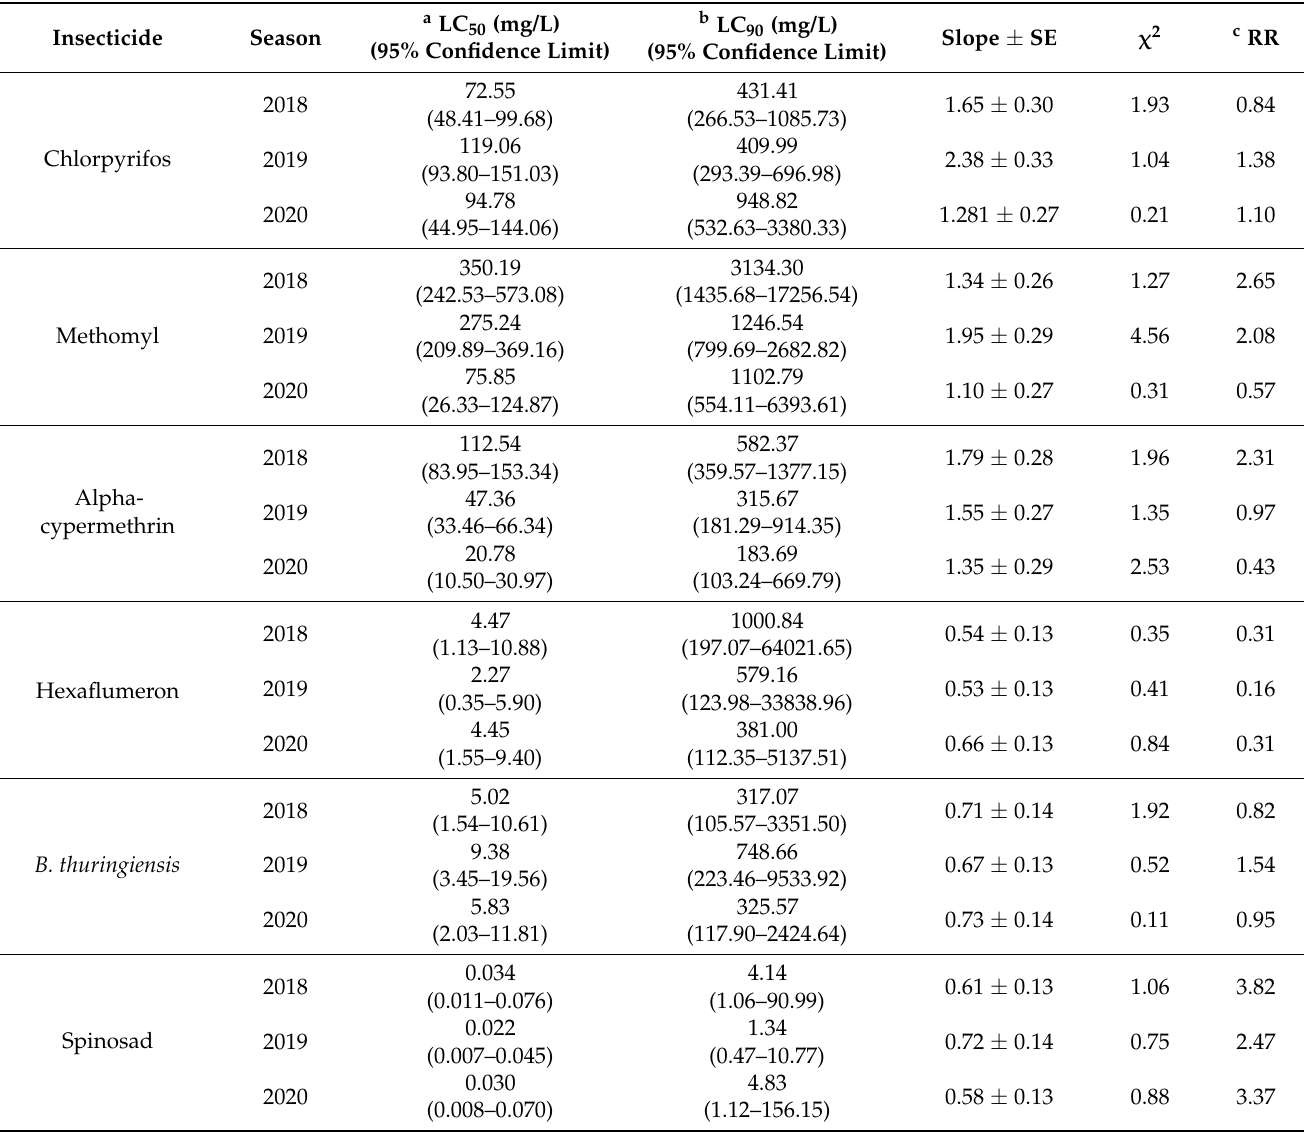
Table 4. Susceptibility of the fourth instar larvae of Beheira field strain of Spodoptera littoralis to six insecticides over three consecutive seasons (2018 to 2020). Egg masses of S. littoralis , collected over three consecutive seasons (2018 to 2020), were kept in the rearing room until the fourth instar larvae. Six concentrations of each tested insecticide were prepared, then castor bean leaves were immersed in each concentration for 20 s. For each concentration, 50 larvae were used to calculate the LC 50 , LC 90 and the resistance